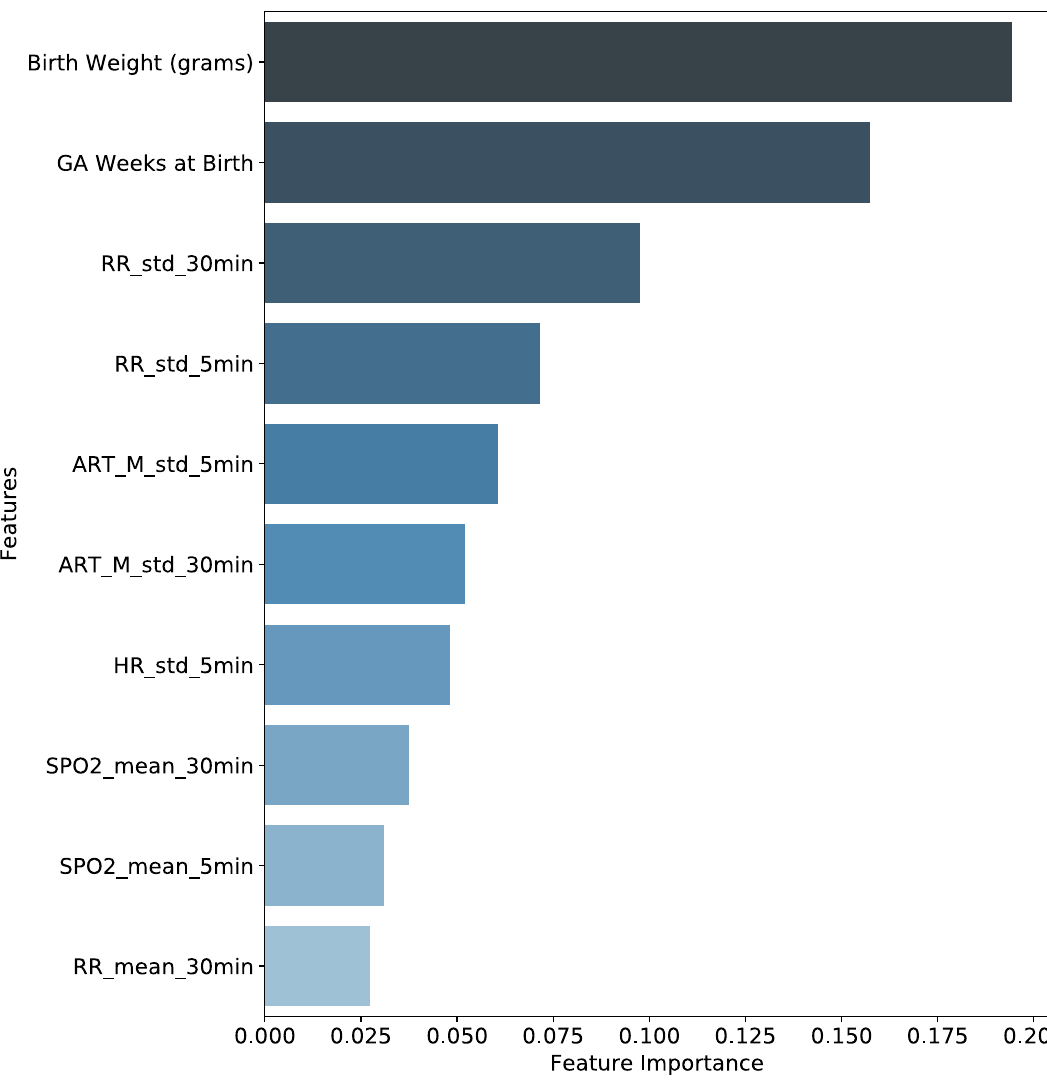
Figure 2. Per-timepoint random forest top ten features ranked by importance. Ten most important features of the per-timepoint random forest model, ranked according to the mean decrease in Gini